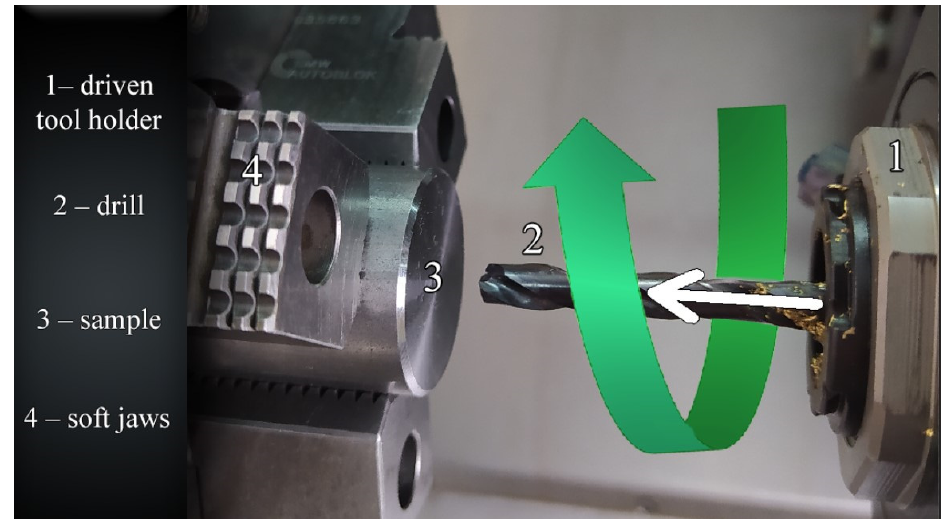
Figure 1. First kinematic system.